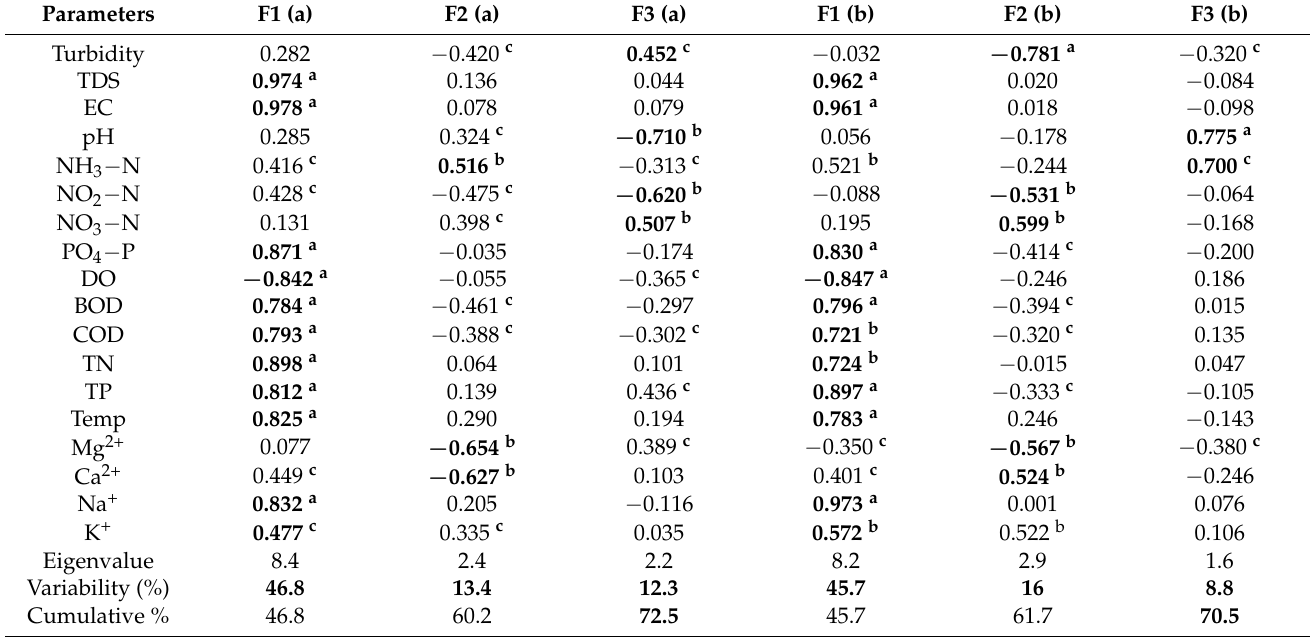
Figure 4. Factor loadings derived from scree plot and eigenvalue for LHW and three factors are retained for dry ( a ) and wet ( b ) seasons. Table 9. Matrix of factor loadings calculated based on water quality parameters measured in the period from May to January in the Lake Hawassa Watershed and factor loadings of variables on the first three PCs extracted by using eigenvalue for both wet (a) and dry (b)